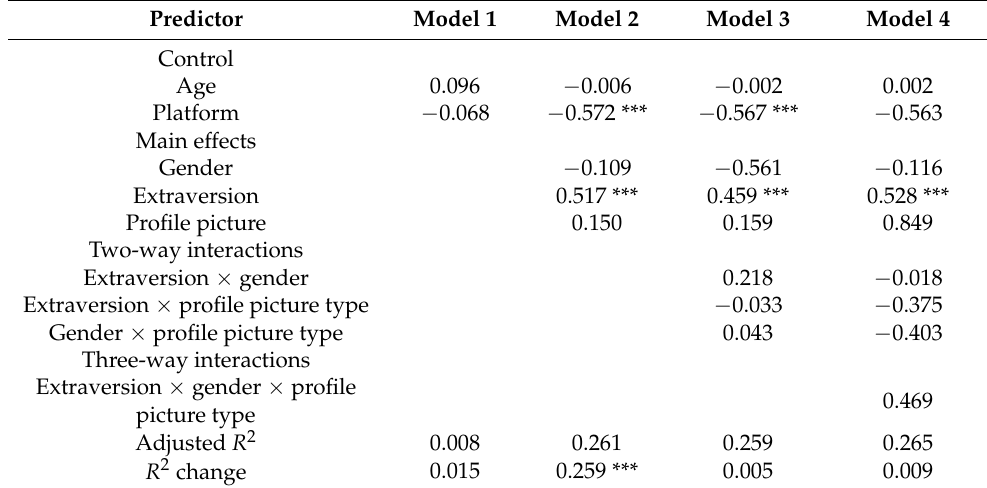
Table 3. Hierarchical multiple regression models for extraversion predicting life satisfaction.